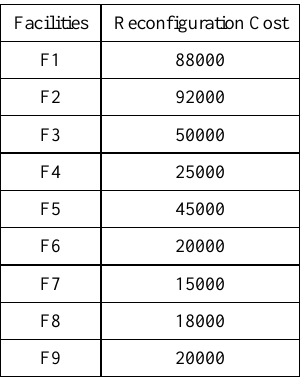
Table 7. Reconfiguration cost